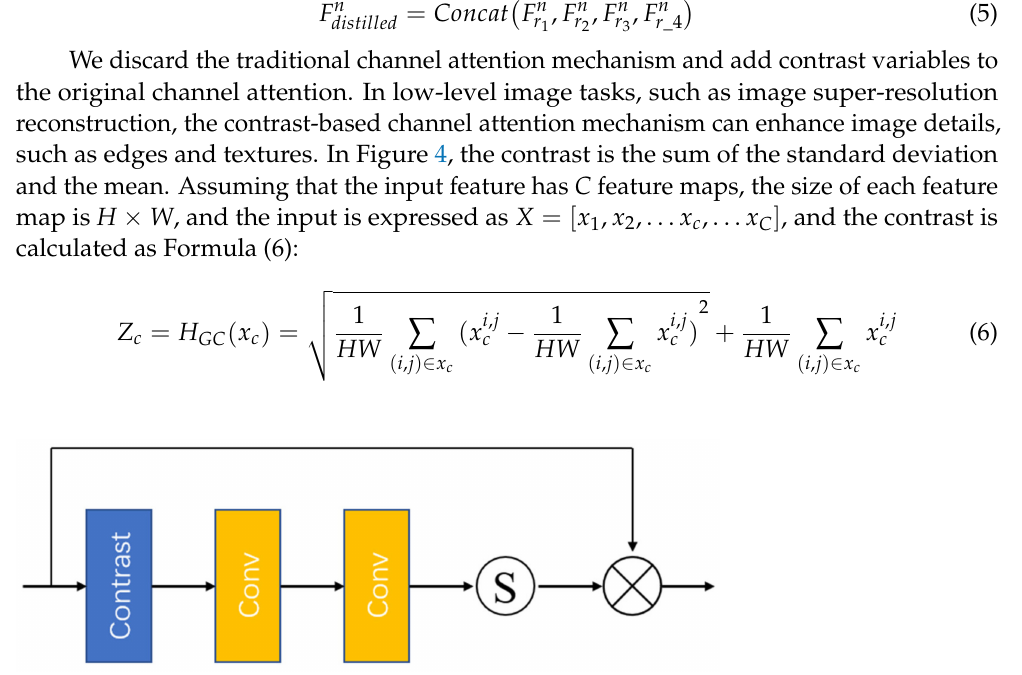
Figure 4. Contrast-based channel attention mechanism (S is sigmoid